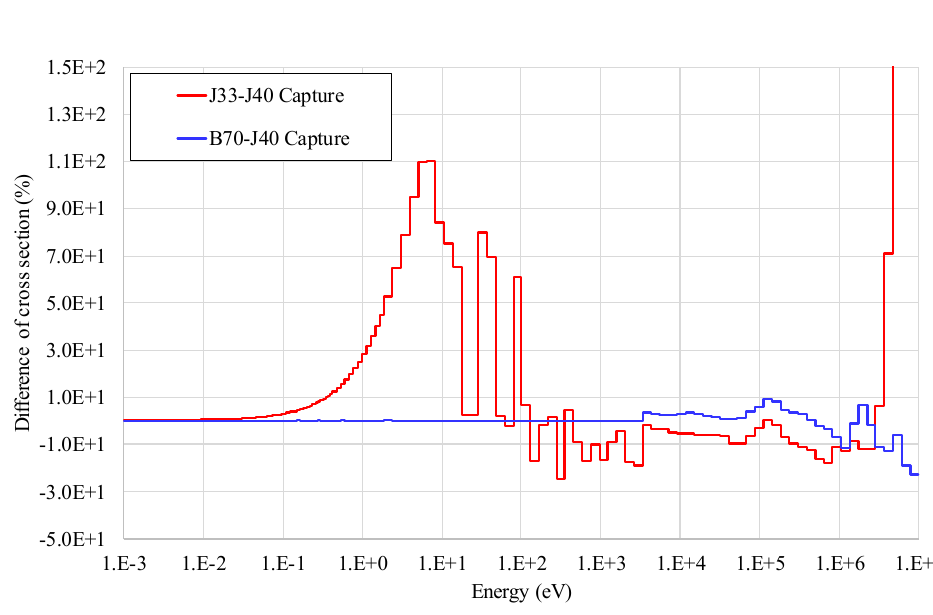
Figure 5. Differences of 232 Th capture cross